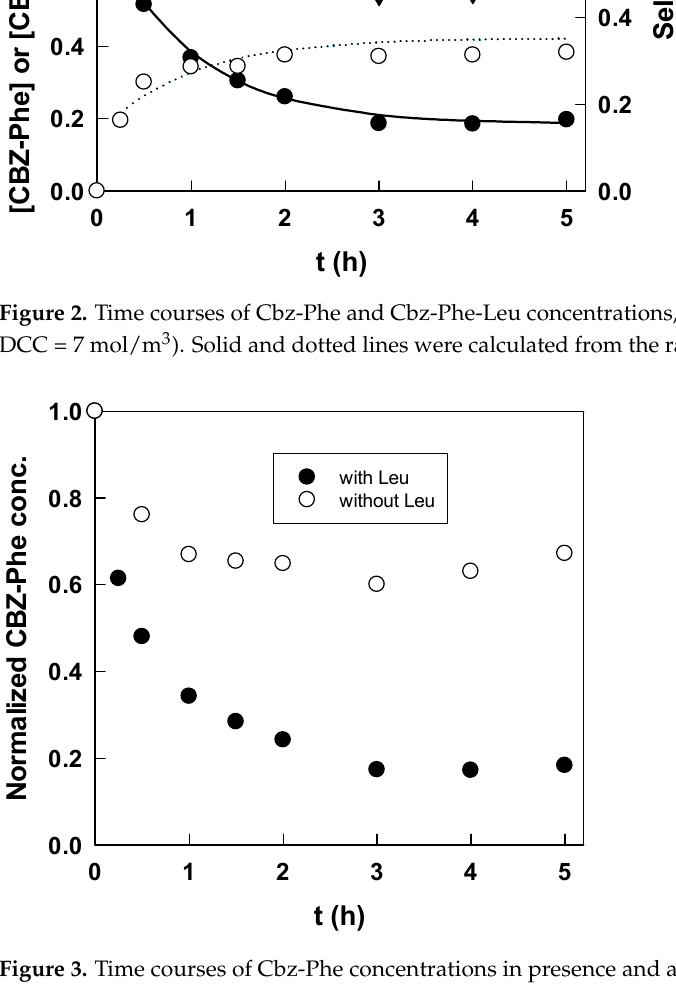
Figure 3. Time courses of Cbz-Phe concentrations in presence and absence of Leu in aqueous core ( w 0 = 28, pH 5, DCC = 7 mol/m 3 ).